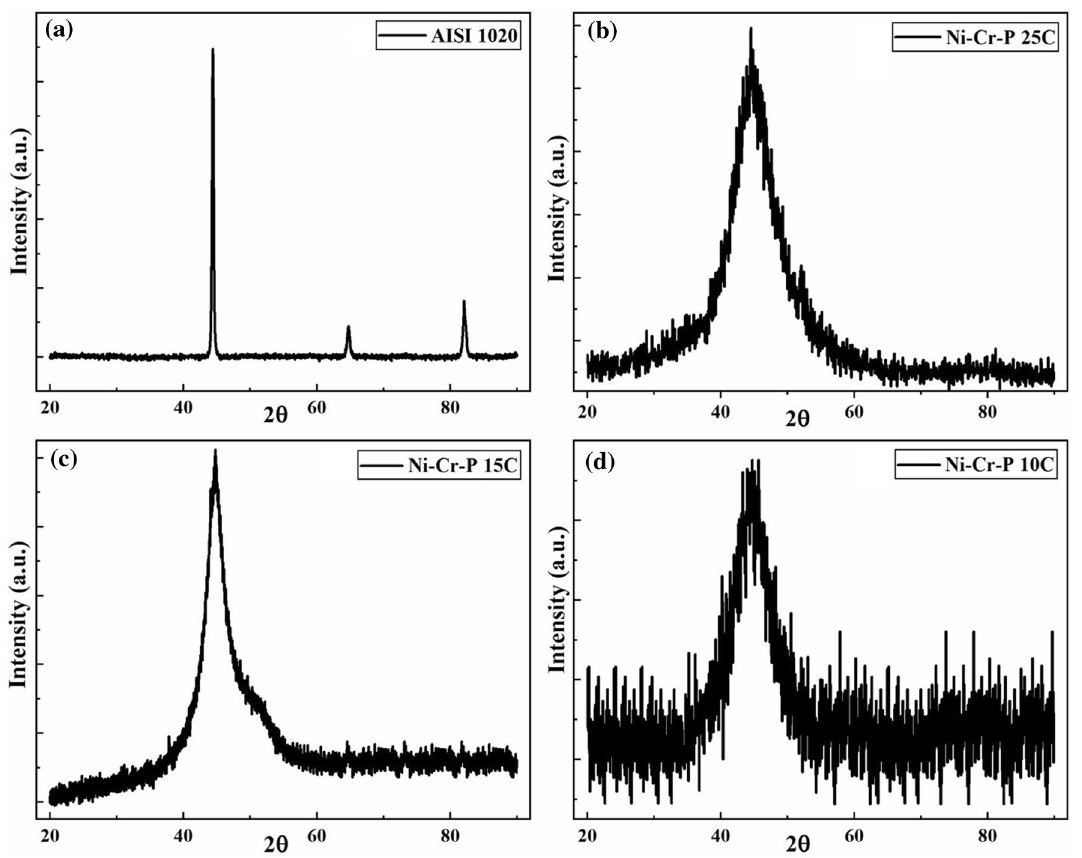
Fig. 6 XRD spectra of a AISI 1020 low-carbon steel, and Ni–Cr–P alloy pulse-electrodeposited at b 25 °C (± 3 °C), c 15 °C (± 3 °C), and d 10 °C (± 3 °C), having constant pH (3.0)